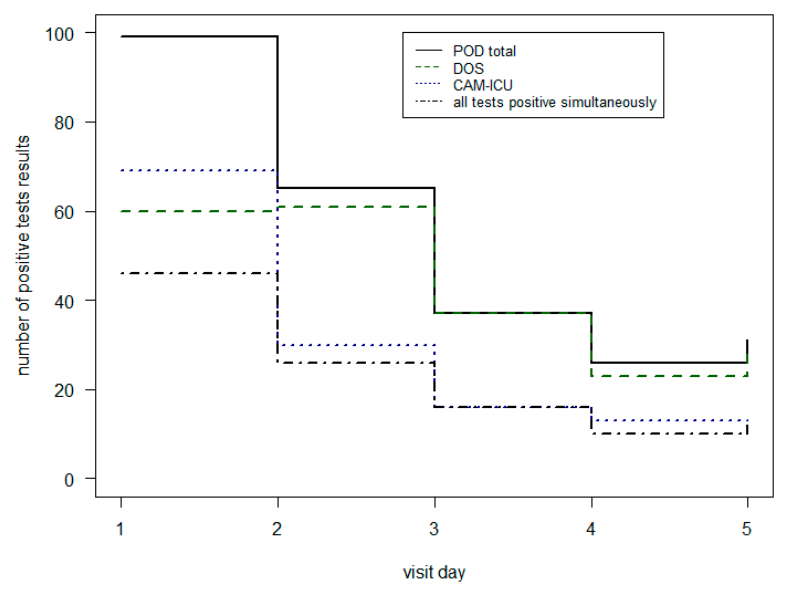
Figure 2. Comparison of positive POD tests in ICU and IMC per visit day. Table 5. Comparison of positive POD tests in ICU and IMC.